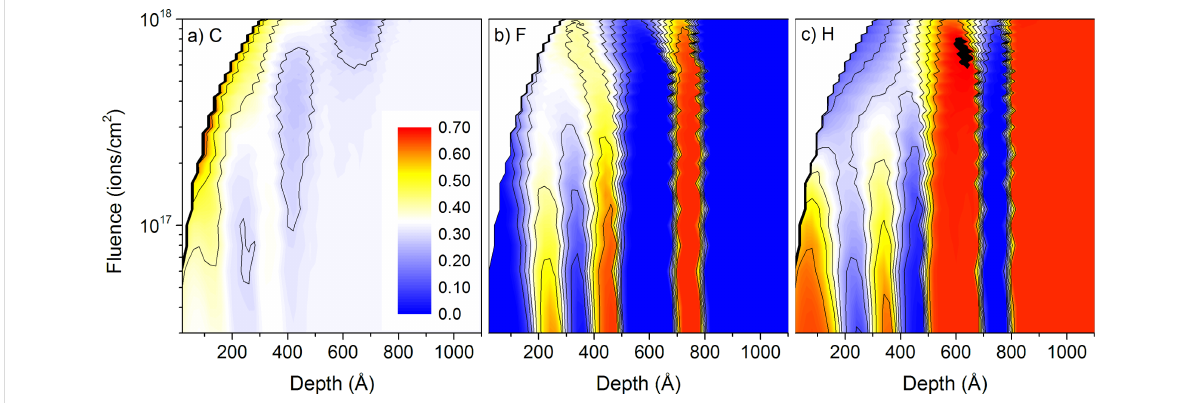
Figure 2: Sample composition as a function of depth and primary ion fluence for 1 keV He + irradiation of sample #1 with the thin-layer configuration: a) for carbon, b) for fluorine, and c) for hydrogen. The colour scale shows concentrations from 0 to 70% and is identical for the three graphs.